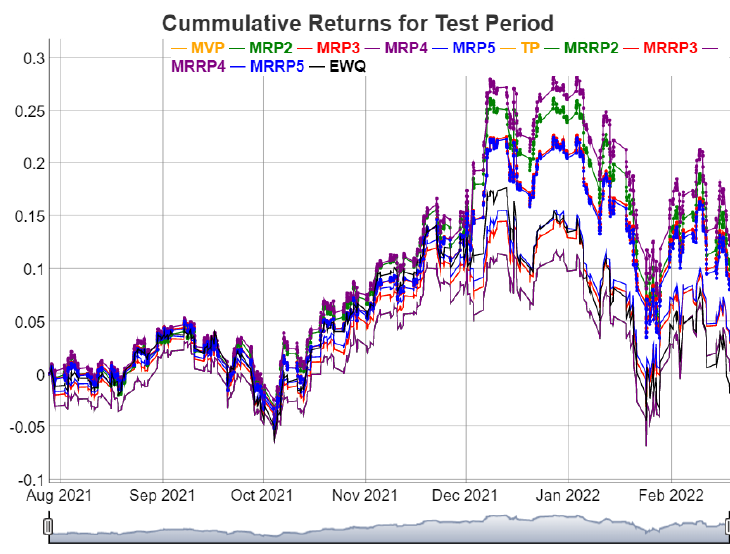
Figure 16. Cumulative returns of